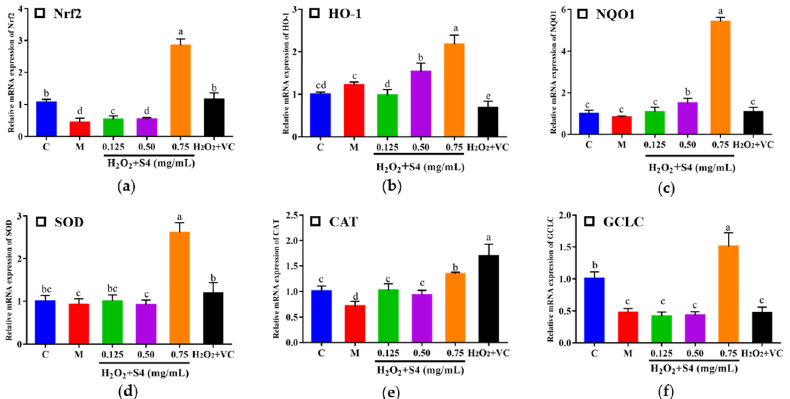
Figure 8. Effects of S4 on the relative expression of key genes in the Nrf2 signaling pathway: ( a ) Nrf2 ; ( b ) HO-1 ; ( c ) NQO1 ; ( d ) SOD ; ( e ) CAT ; ( f ) GCLC . “C” represents the control group, and “M” represents the model group. Data were expressed as mean ± SD ( n ≥ 3, p < 0.05). Different letters indicate significant differences ( p < 0.05).